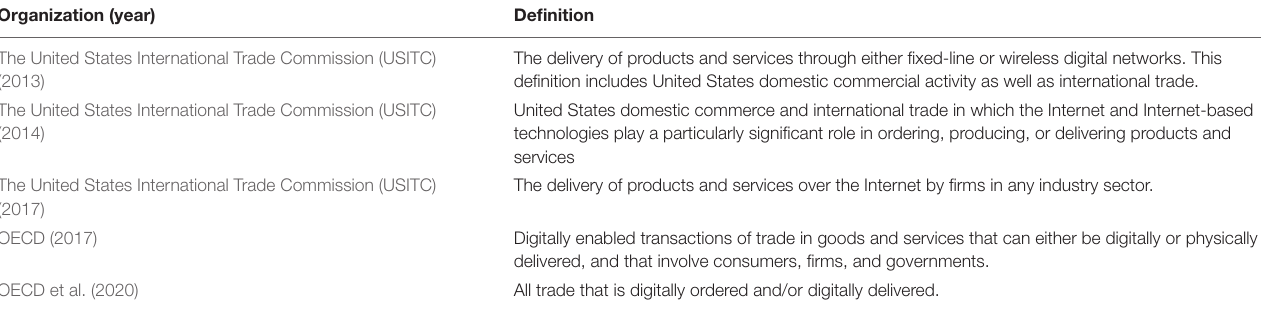
TABLE 1 | Digital trade as defined by various organizations. Organization (year)